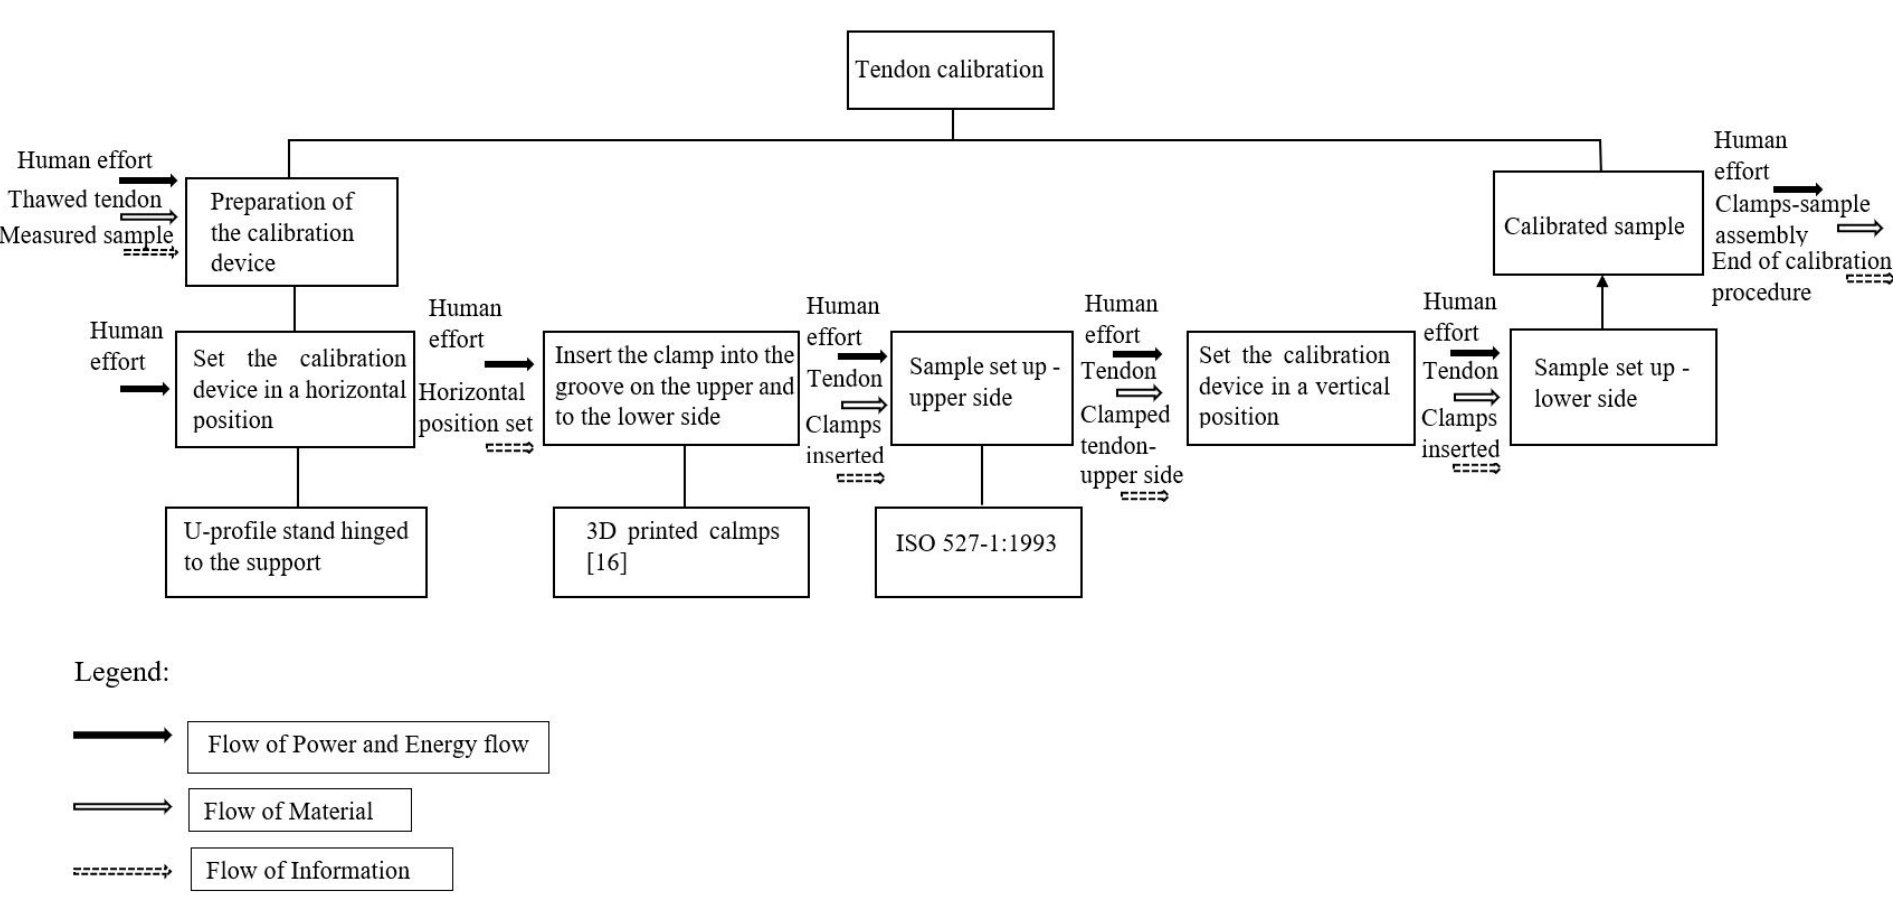
Figure 3. The functional structure of the calibrator.